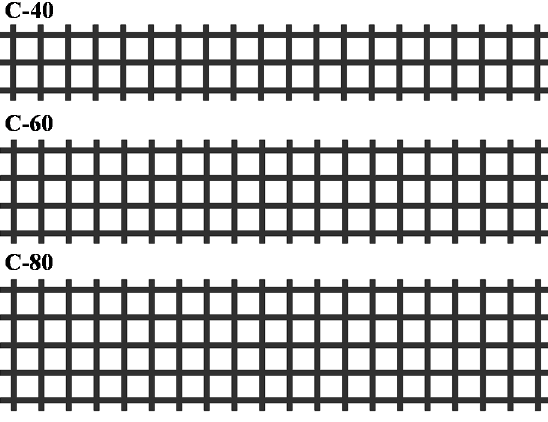
Figure 4. Schematic diagram of carbon fiber grid width.